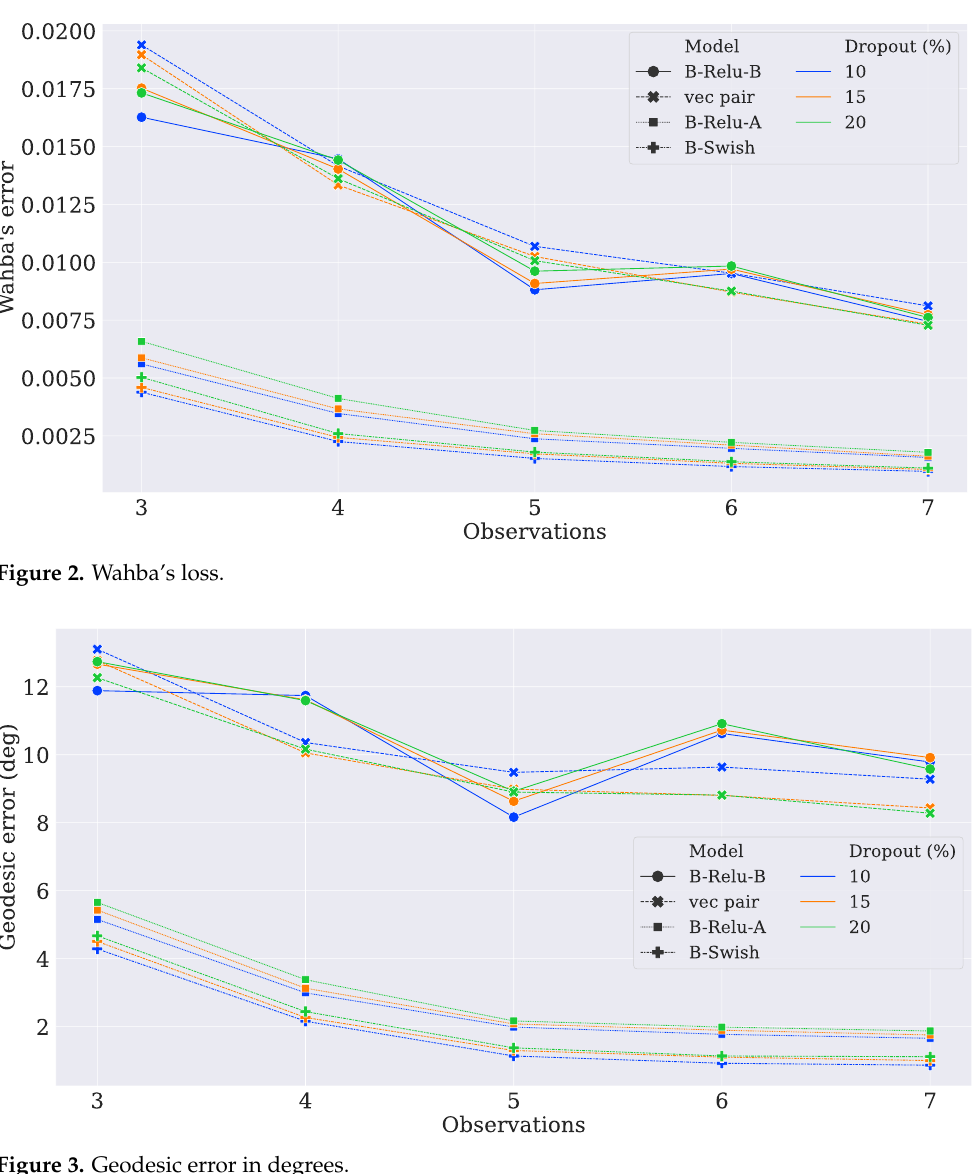
Figure 3. Geodesic error in